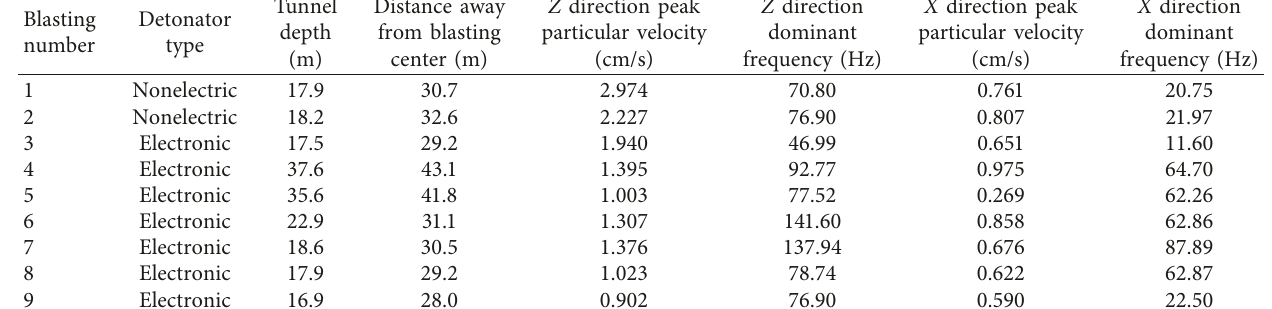
Table 1: Vibration characteristics of the